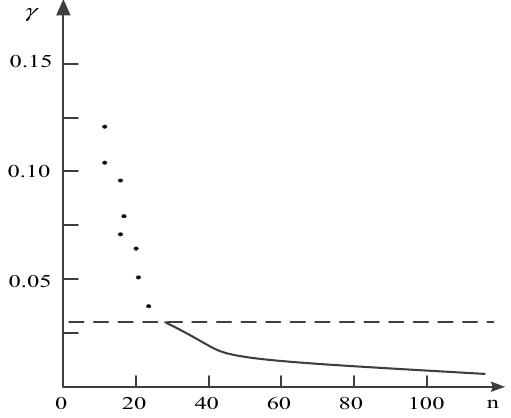
Figure 8. Example and schematic: ( A ) distribution of random points and ( B ) the ρ and δ values of each point. Figure 8 . Example and schematic: ( a ) distribution of random points and ( b ) the (cid:2025) and (cid:2012) values of each point.